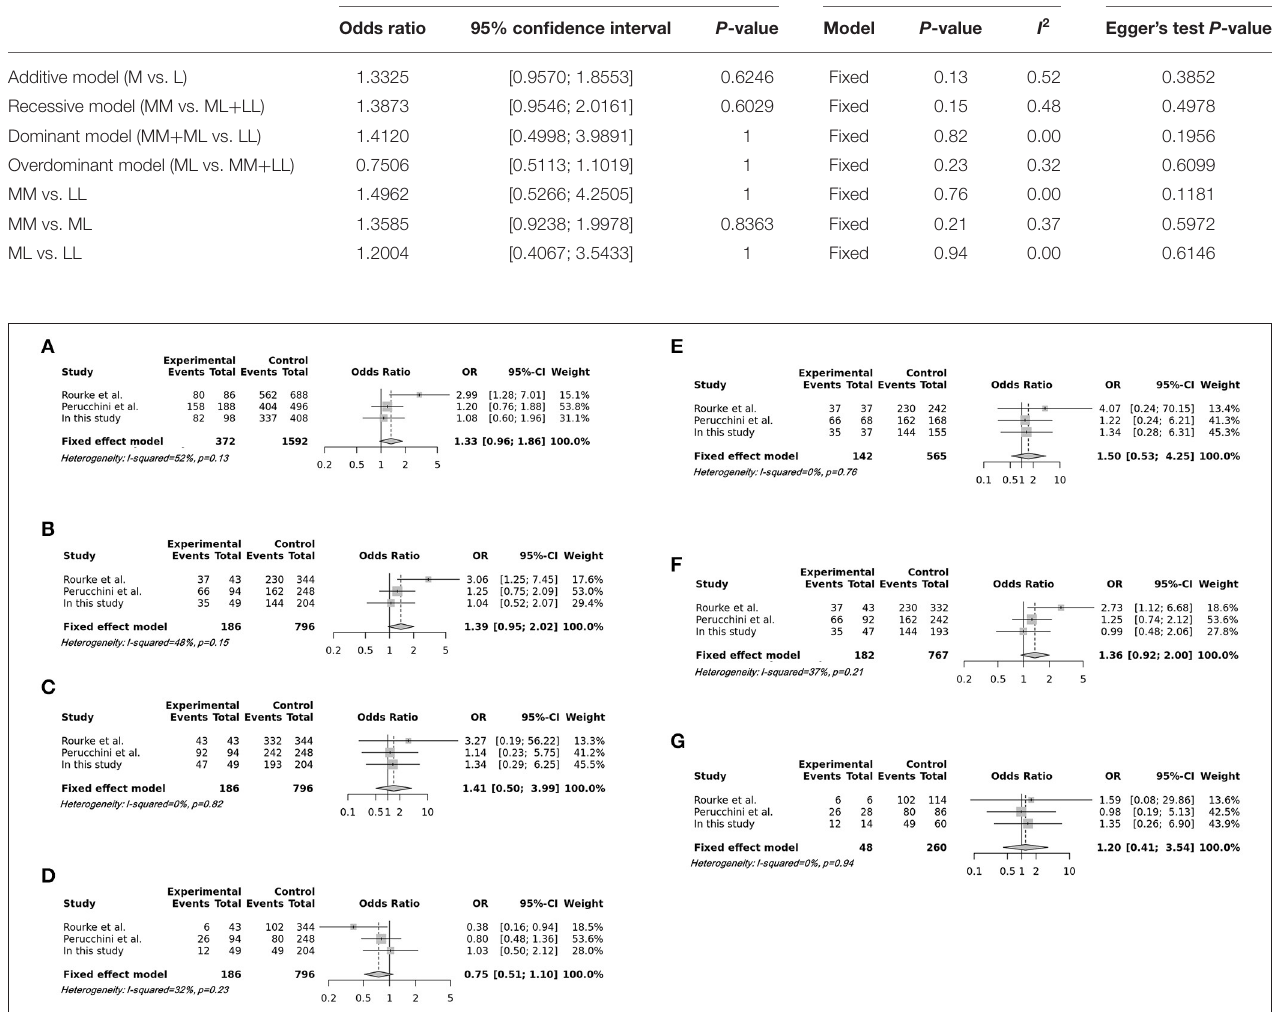
TABLE 2 | Meta-analysis of the association between the M132L SNP of the PRNP gene and susceptibility to CWD. Genetic